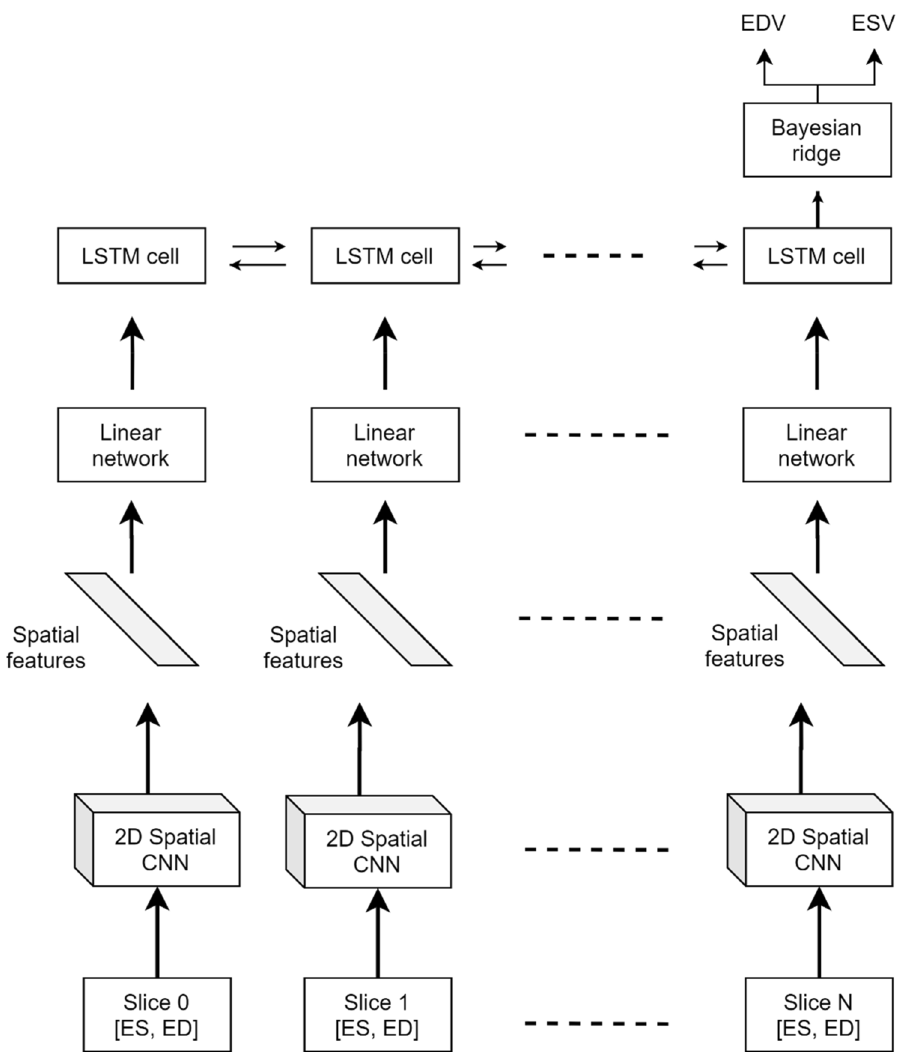
Figure 7. Architecture of the Spatial Feature Encoding Recurrent network for Abstracting high-level patient features (SFERA) model. The model takes as input a SAX stack of variable number of slices which comprise individual ED and ES frames. The network outputs the ESV and ESV, which are subsequently used to compute the ejection